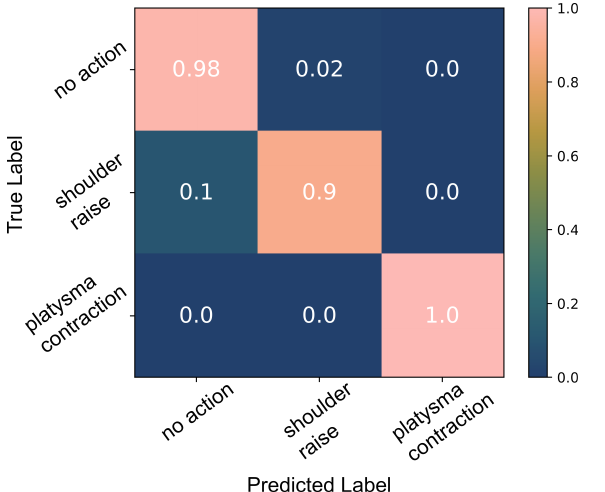
Figure 12. Classification results of the platysma sensor data using the thresholding